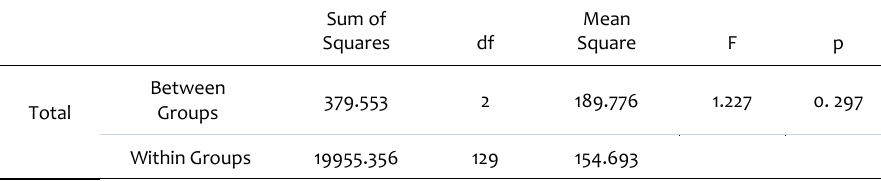
Table 10. Students' reading motivation scores in relation to family income